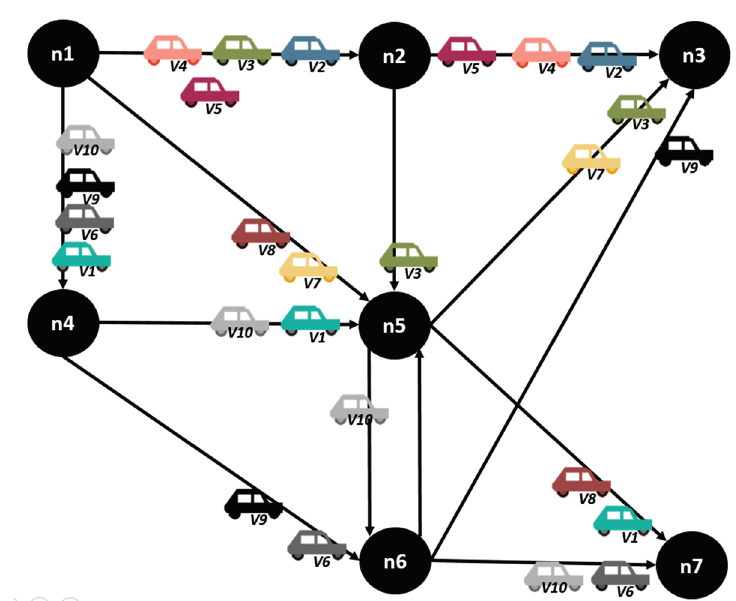
Figure 12. Overall assignation of the